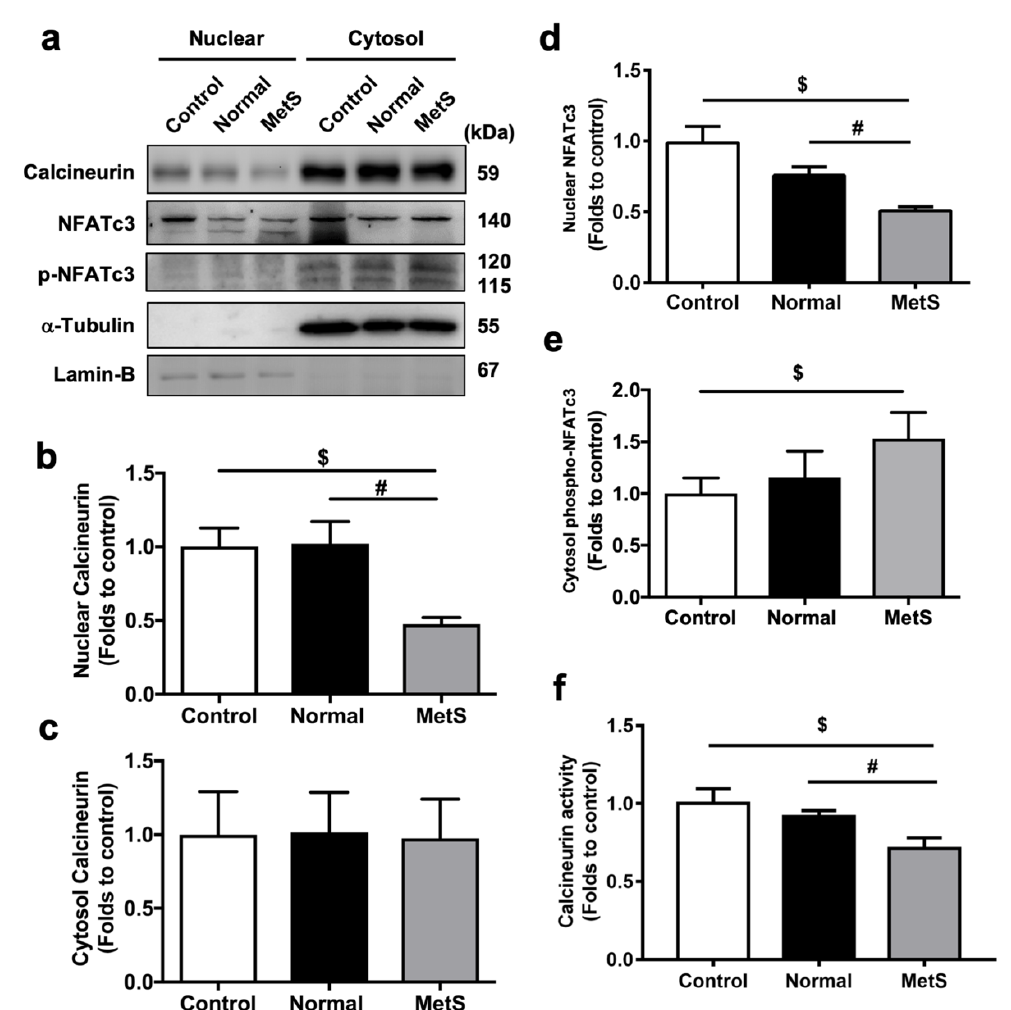
Figure 3. MetS-VLDLs suppressed calcineurin–nuclear factor of activated T-cells (NFAT) signaling pathways. ( a ) Representative bands of western blots ( n = 4 for each group) for nuclear and cytosolic fractions of calcineurin, NFAT, and phosphorylated NFAT in proteins. ( b ) Reduced nuclear calcineurin in the MetS-VLDL group (MetS) ( n = 4; $ P = 0.037 vs. control, # P = 0.04 vs. normal-VLDL group (Normal)). ( c ) Unchanged cytosolic expression of calcineurin protein ( n = 4, P = 0.9377). ( d ) Reduced nuclear NFAT in the MetS group ( n = 4; $ P = 0.007, # P = 0.009). ( e ) Increased phosphorylated NFAT in the cytoplasm of the MetS group ( n = 4, $ P = 0.04). ( f ) Reduced calcineurin activity in the MetS group ( n = 6; $ P = 0.0001, # P =